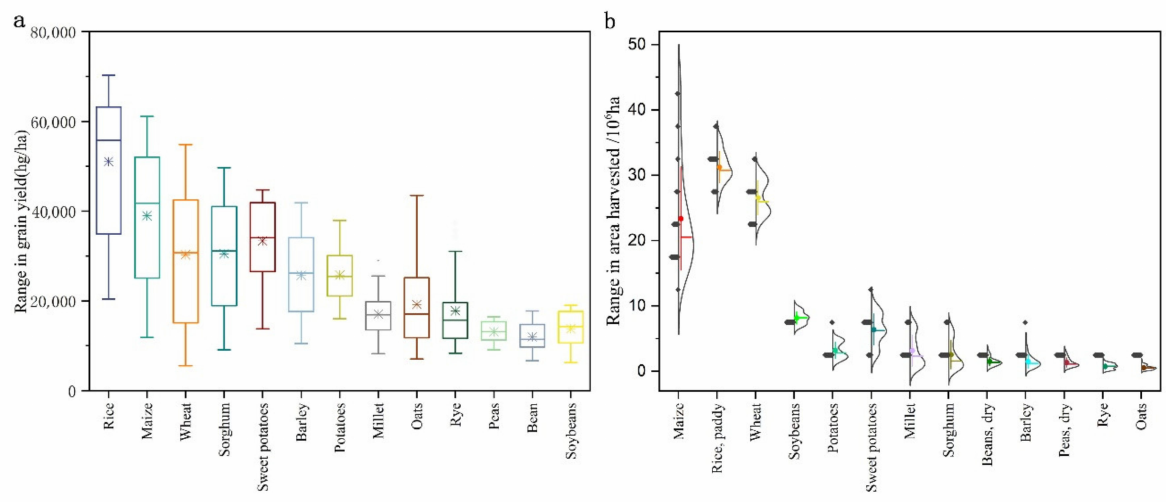
Figure 5. Ranges in grain production yield ( a ) and arable land area ( b ) during 1961–2018. Projection 1: Here, we project that increases in grain production maintain their current pace (P1). These increases will be the combined result of various factors, mainly the adjustment of the cropping structure. Over the past 58 years, grain output in China has increased at an average rate of 1.4% per year, but the growth rate has declined to 0.62% in the last decade and has decreased at a rate of approximately 0.5% per decade. Projection 1 assumes that grain production growth rates will decrease by 0.1% per decade to reach 709 Mt in 2050, an increase of 51.2 Mt compared with the current value (Figure 6). As the base option for our proposal, we set a relatively small increment.